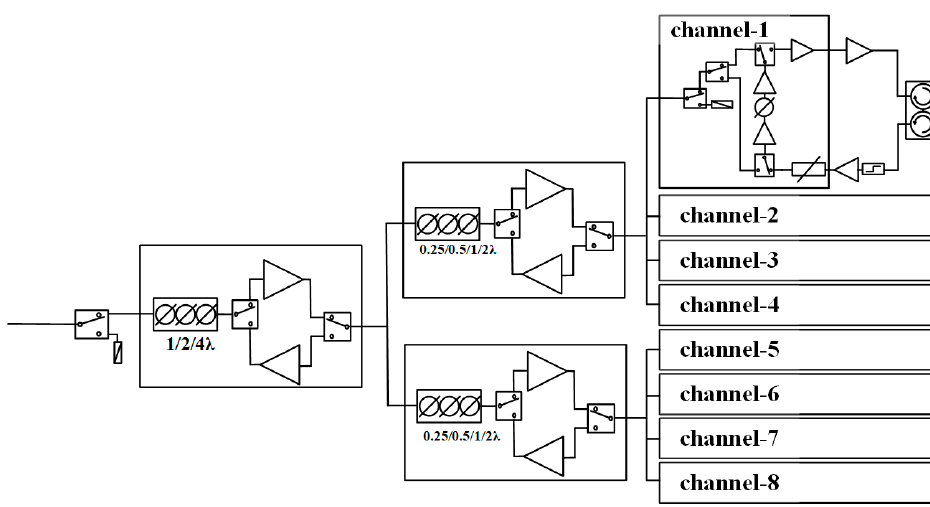
Figure 1. Topography of the 8-channel T/R module with 7-bit TTD.